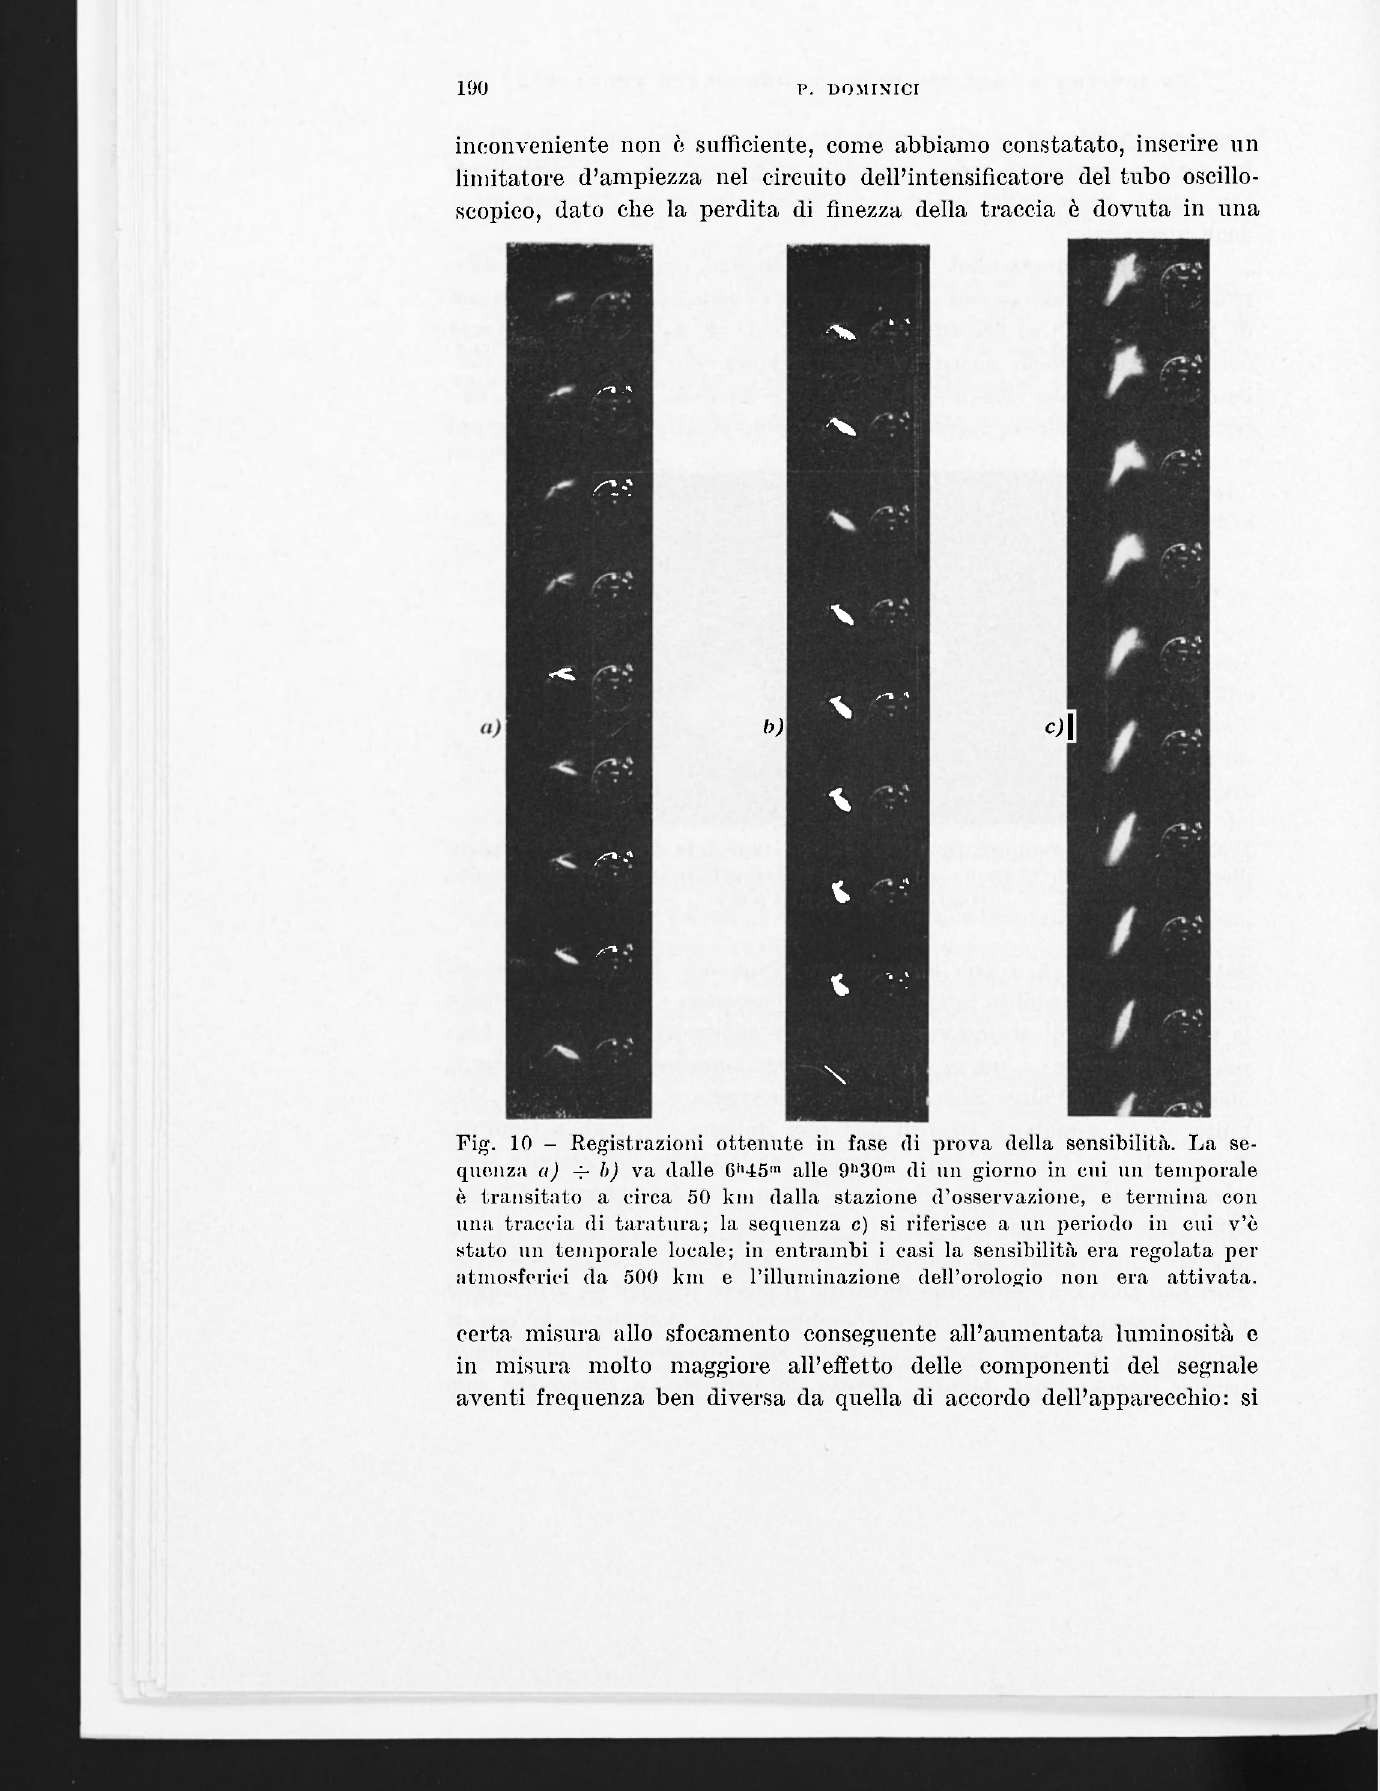
Fig. 10 - Registrazioni ottenute in fase di prova della sensibilità. La se- quenza a) -f- b) va dalle 6 h 45 m alle 9"30 m di un giorno in cui un